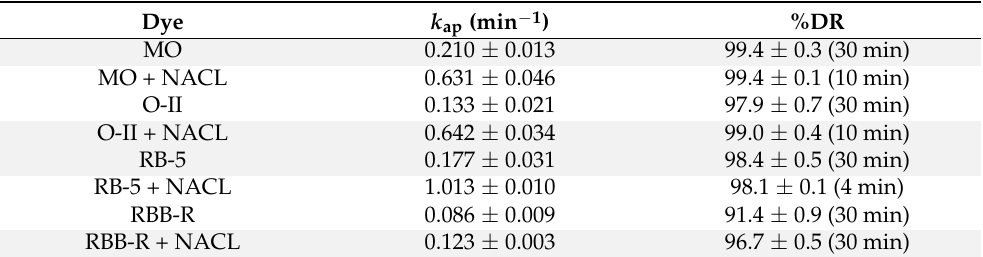
Table 1. Apparent rate constant and percentage of dye removal of the ozonation AOP without and with 50 g NaCl/L (the standard deviations of at least three independent repetitions are shown). The reaction time necessary to achieve the percentage of dye removal is shown in parentheses. Fitting of the integrated first-order kinetics resulted in R 2 >